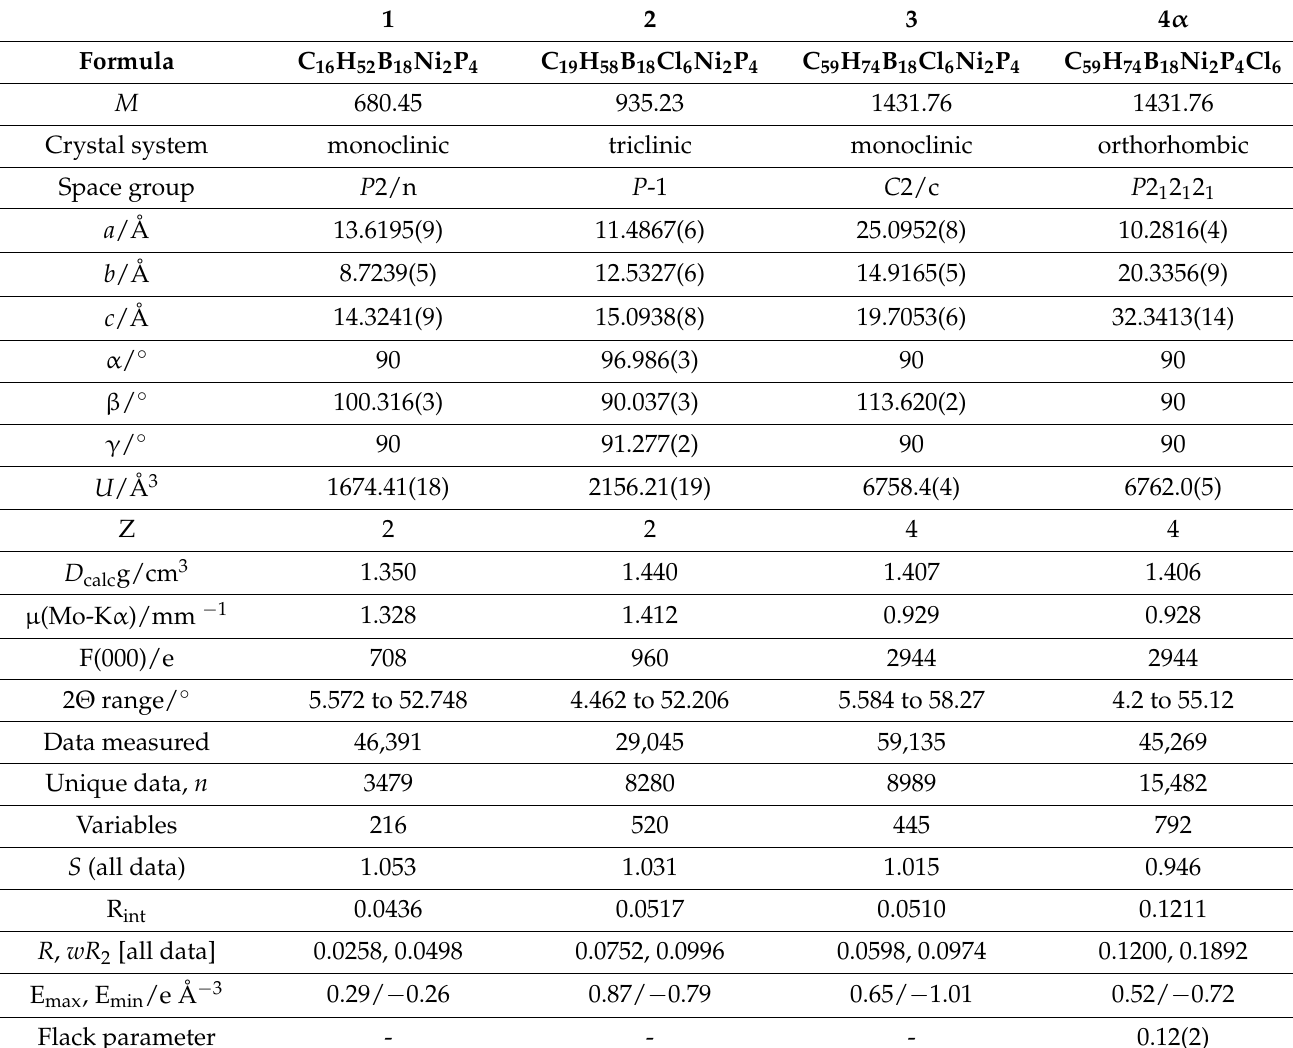
Table 1. Crystallographic data for compounds 1 – 4 α